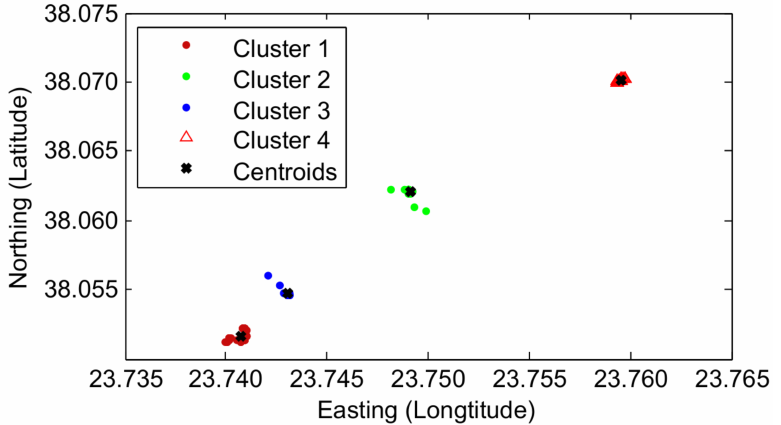
Figure 9. Spatial distribution of the sensor data clusters.